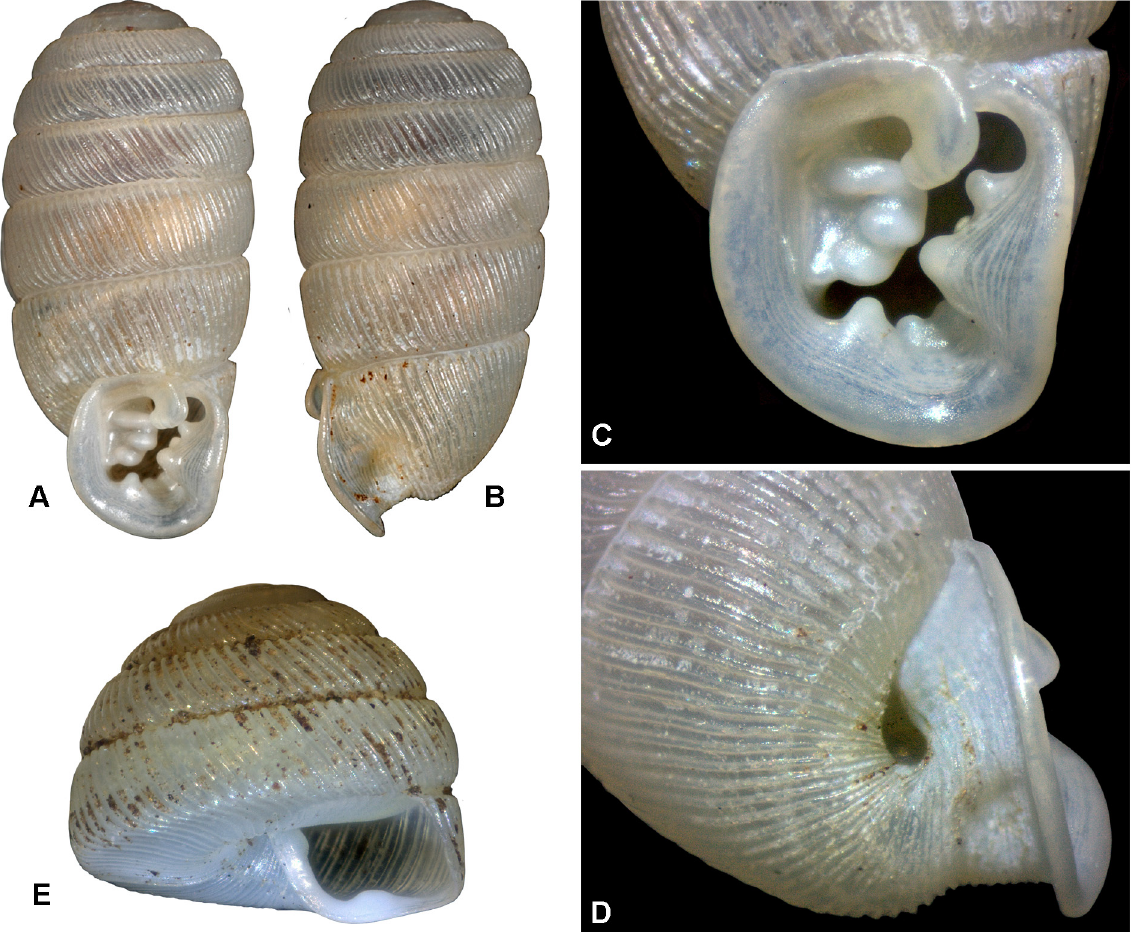
Fig. 1. Gulella davisae sp. nov. A–D . Holotype, height 6.1 mm, diameter 2.9 mm (NMSA P0418/ T4086). E . Juvenile specimen showing apertural dentition, diameter 2.7 mm (paratype, NMSA P0235/